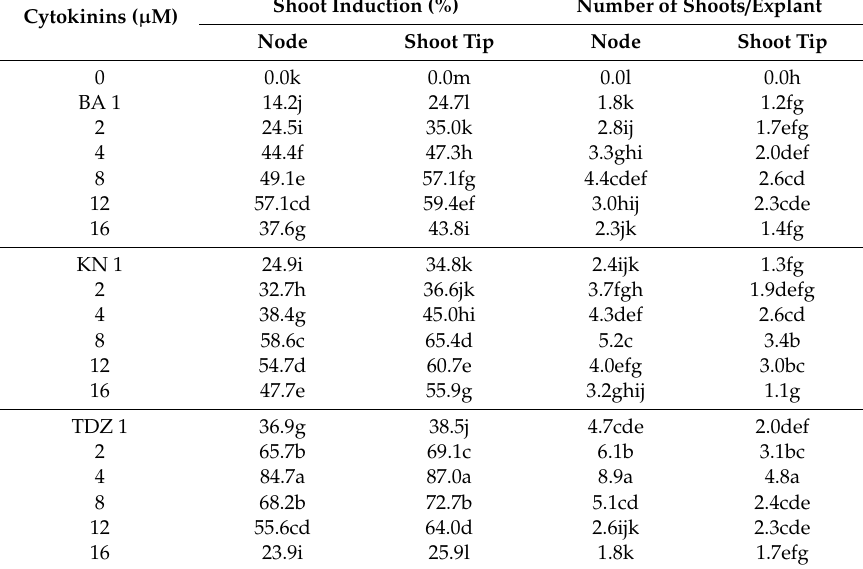
Table 1. Impact of cytokinins on multiple shoot induction in the node and shoot tip explants of Mertensia maritima .